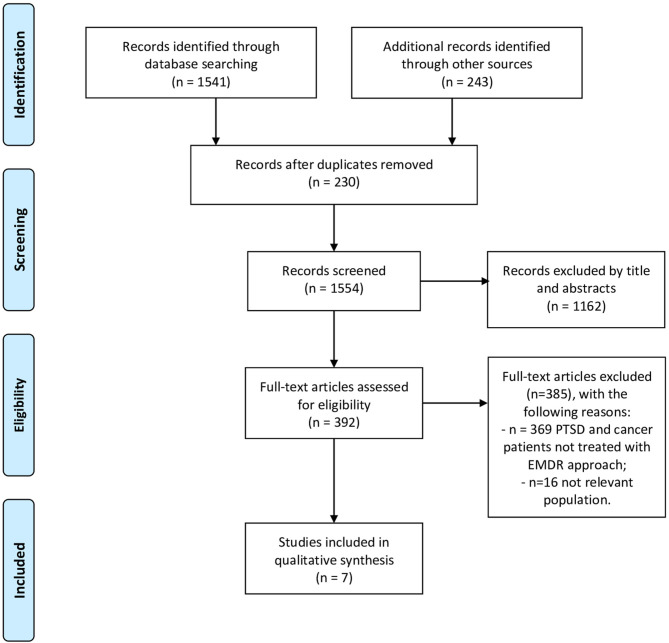
PRISMA flow diagram.